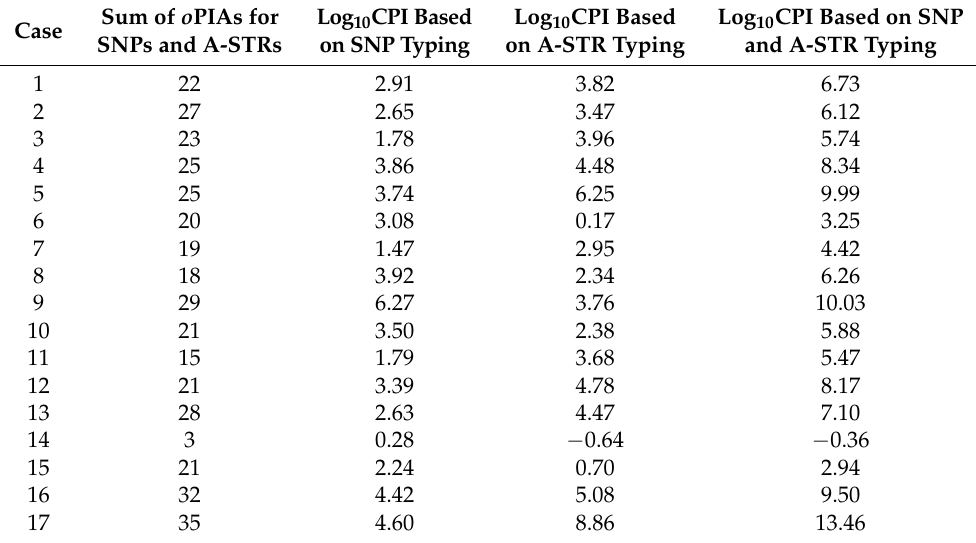
Table 2. Log 10 CPI values for 17 families.